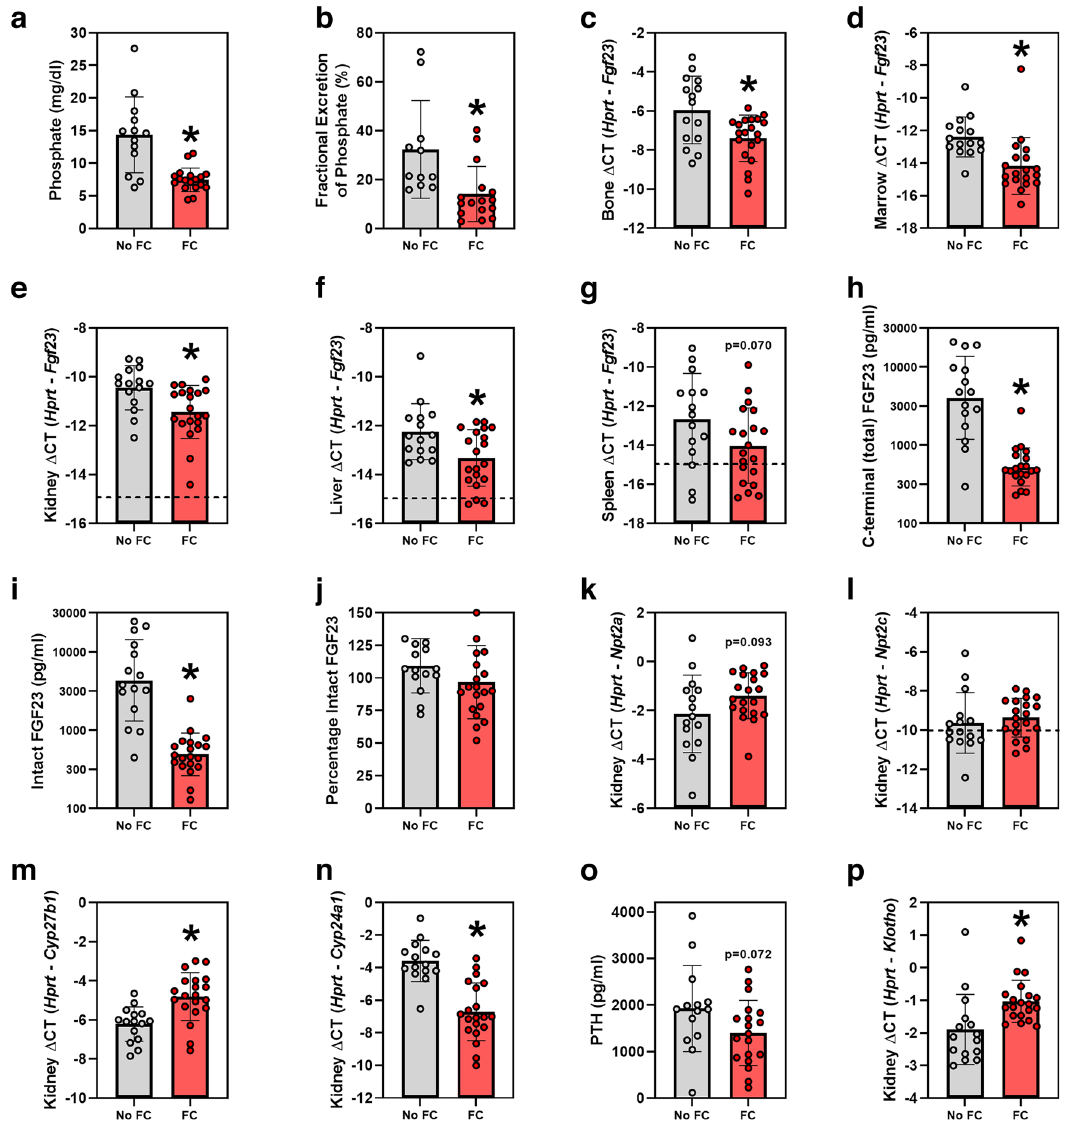
Figure 1. Mineral metabolism parameters in Col4α3 knockout mice treated with or without 1% ferric citrate (FC) added to the diet. Parameters measured include: ( a ) serum phosphate, ( b ) urinary fractional excretion of phosphate, ( c ) bone Fgf23 mRNA, ( d ) marrow Fgf23 mRNA, ( e ) kidney Fgf23 mRNA, ( f ) liver Fgf23 mRNA, ( g ) spleen Fgf23 mRNA, ( h ) plasma C-terminal (total) FGF23, ( i ) plasma intact FGF23, ( j ) plasma percentage intact FGF23, ( k ) kidney Npt2a mRNA, ( l ) kidney Npt2c mRNA, ( m ) kidney Cyp27b1 mRNA, ( n ) kidney Cyp24a1 mRNA, ( o ) plasma parathyroid hormone, and ( p ) kidney Klotho mRNA. In figures ( e ), ( f ), ( g ), and ( l ), dotted lines correspond to quantitative real-time PCR cycle threshold values for blank samples. Data are presented as means and standard deviations. Two-tailed t-tests are used to compare groups, * p <